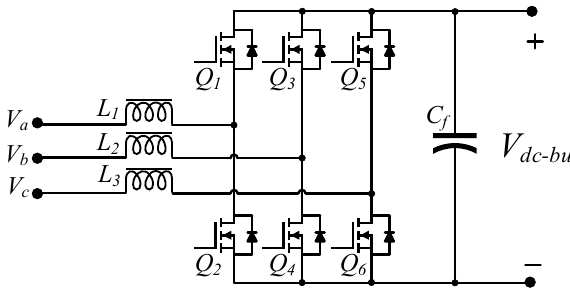
Figure 17. Three-phase bridgeless boost converter. Figure 17 . Three-phase bridgeless boost converter.